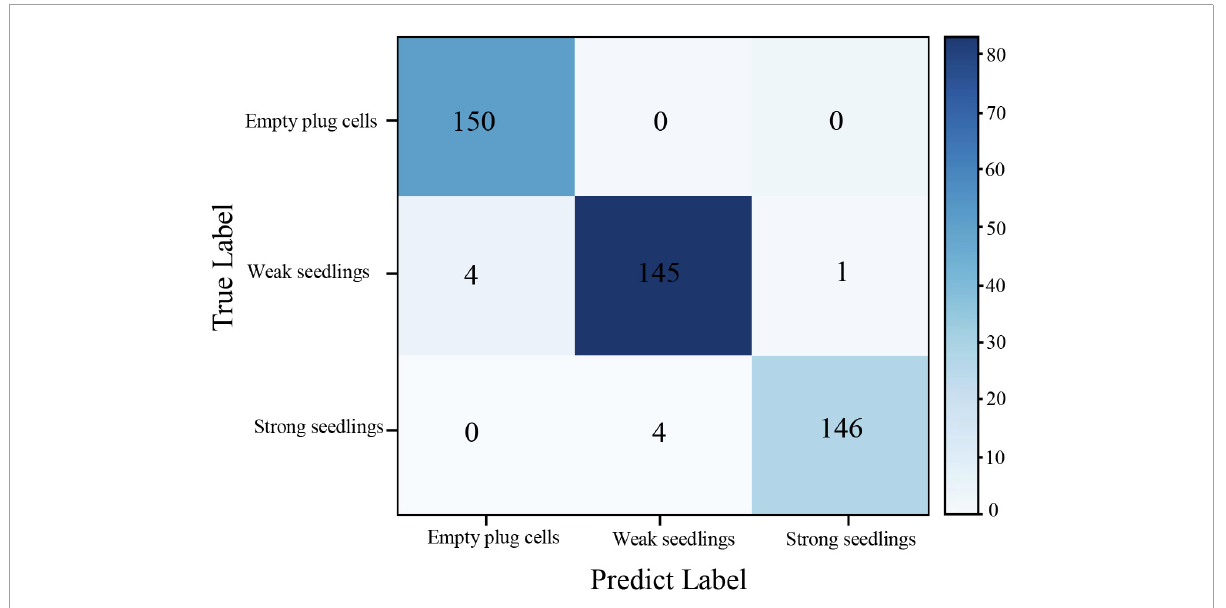
FIGURE12 The EfficientNet-B7-CBAM model confusion